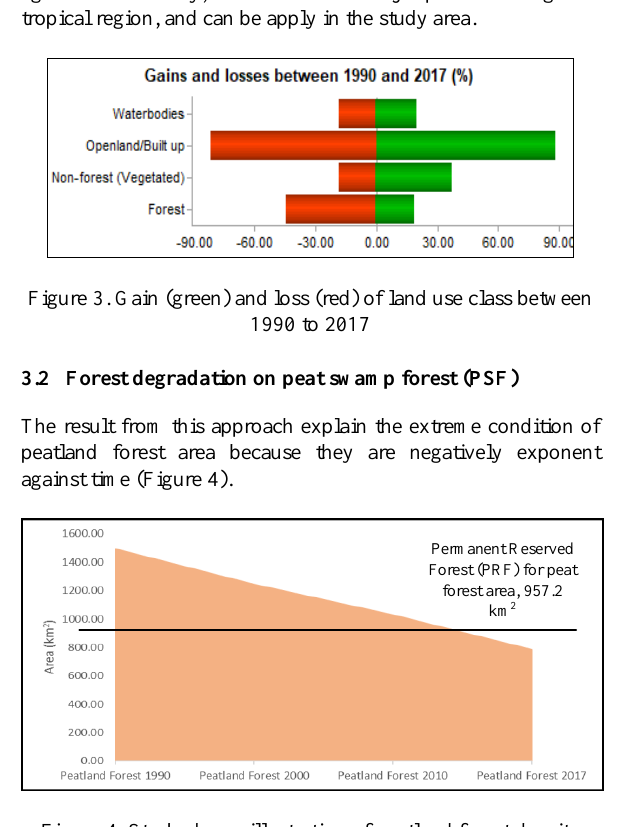
Figure 4. Stacked area illustration of peatland forest density from 1990 to